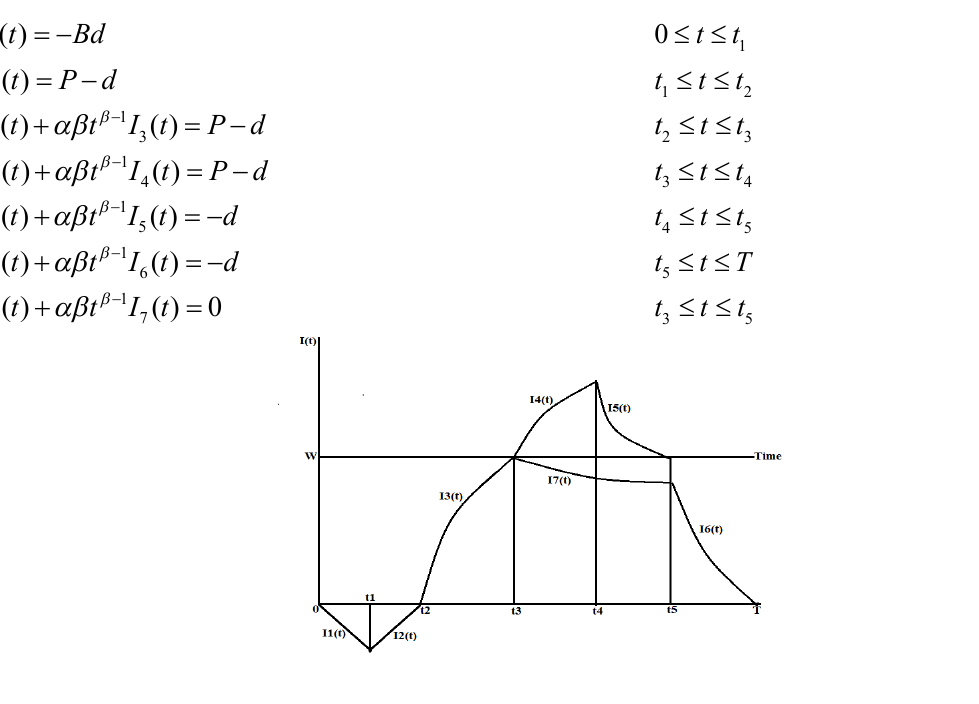
Fig. 2. Two warehouse model which is starts from